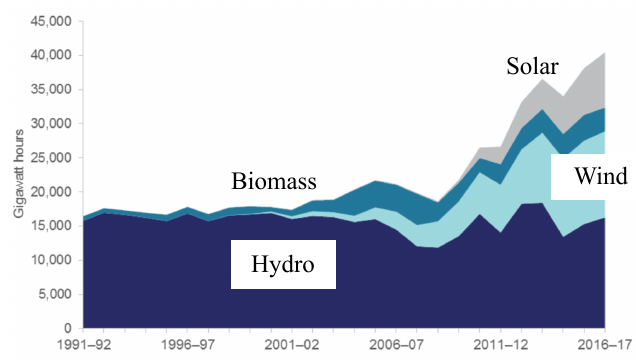
Figure 8. Australian electricity generation from renewable sources [9]. the Congress decides to renew it.